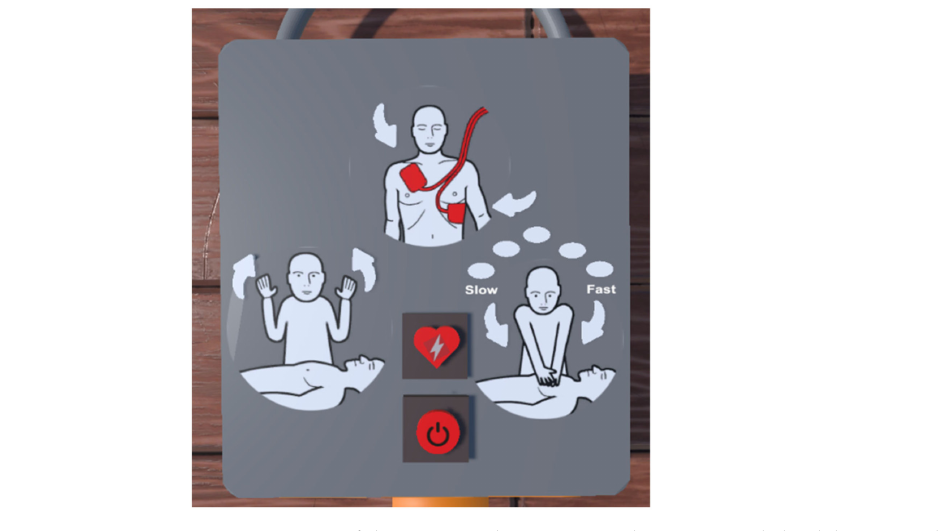
Figure 5. View of the AED. In the center are the power and shock buttons. The arrows on the images act as simulated LEDs and flash to communicate the current step. The top image displays the need to place the shock pads in the locations where the arrows are pointing. The left image conveys the need to stop touching the patient while the AED analyzes their heart rhythm. The right image corresponds to performing